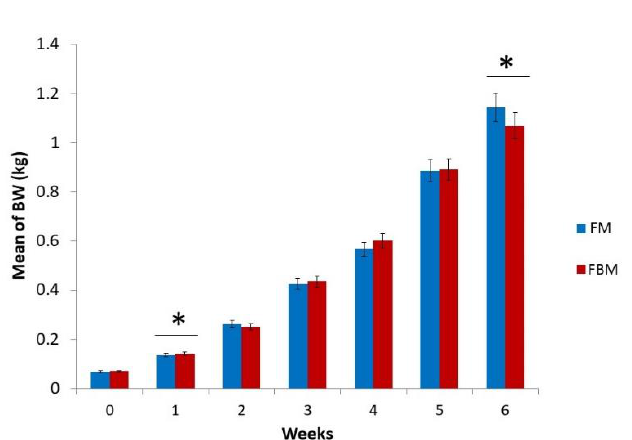
Figure 1: Distribution of the mean of chicken’s BW over 6 weeks growth in both chicken groups. BW, body weight; FBM, fish-blood meal; FM, fish meal. *ρ -value <